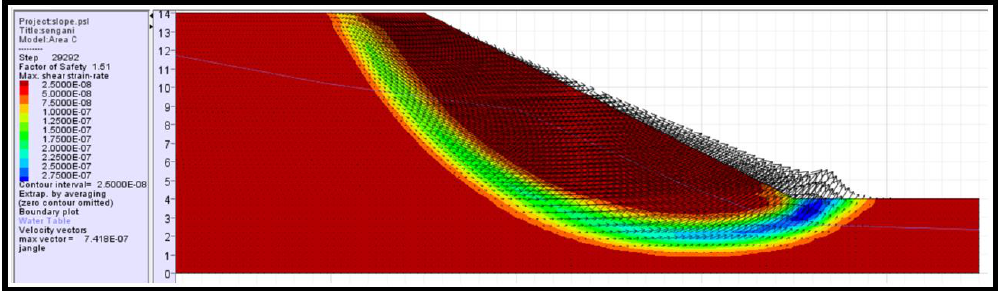
Figure 33. Simulated FoS of the clay loam soil slope using FLACSlope in rainy conditions with a water table with 2000 m 3 volume of water. Note that maximum shear strain simulated ranges between 2.500 × 10 − 8 to 7.418 × 10 − 7 .